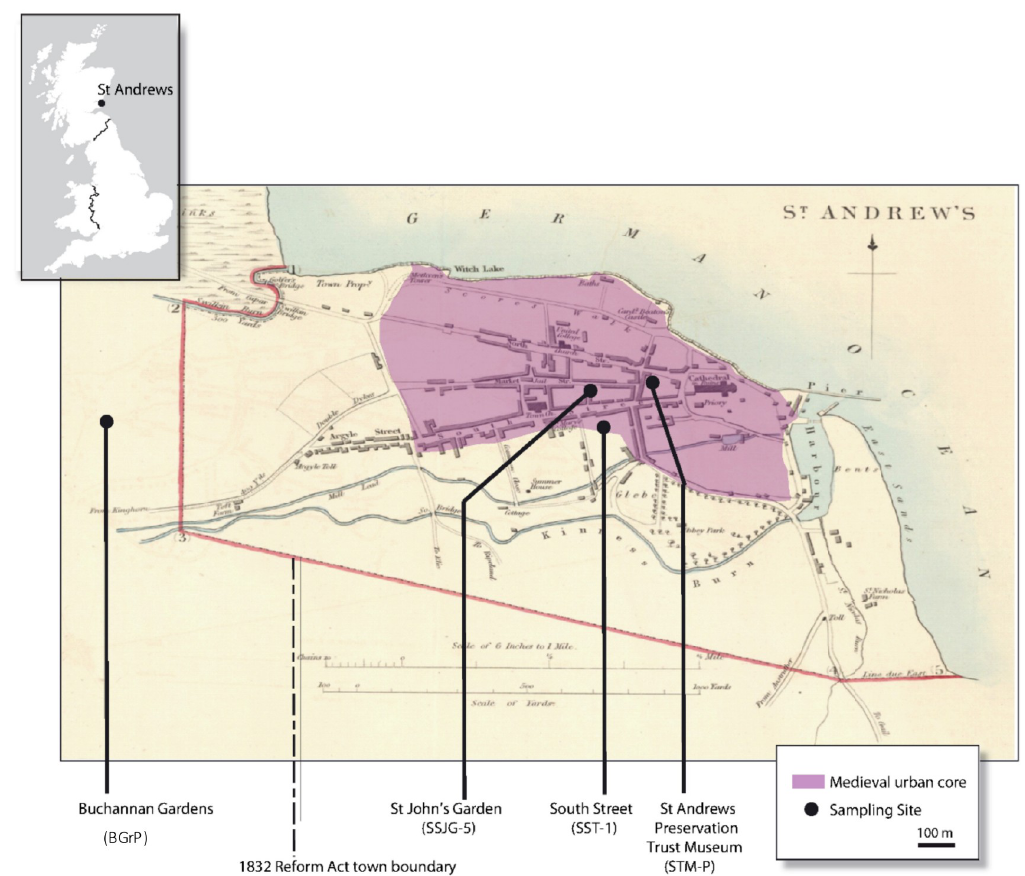
Fig 2. Inset: Location of St Andrews study site in Scotland, UK; Main image: Map of the urban core of St Andrews produced for the Great Reform Act of 1832. The major western and southern boundary is marked as a bold line. Sample site locations in the urban core at St Andrews Preservation Trust Museum (STM-P), St John’s Garden (SSJG-5) and South Street (SST-1) and at an extra-urban location Buchannan Gardens (BGr-P). The original map is reproduced with the permission of the National Library of Scotland (Creative Commons Attribution (CC-BY) licence; https://maps.nls.uk/view/74491935).